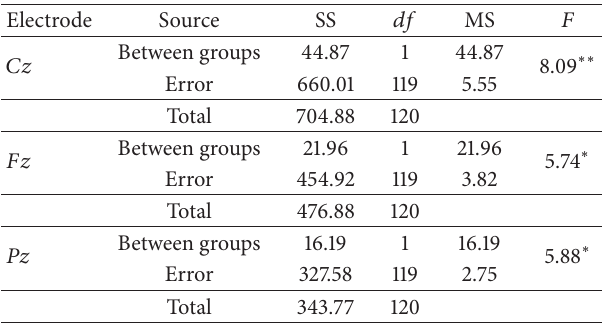
Table 2: ANOVA table for elecrtode